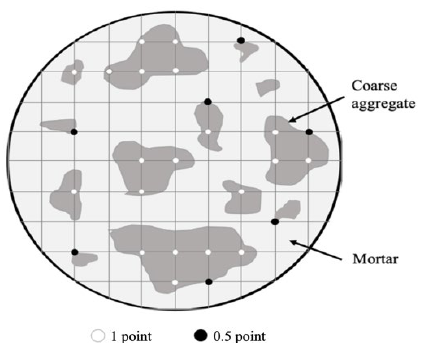
Figure 2. Methodology proposed by Ribeiro [23] to determine the relative percentage of a phase in the sample.